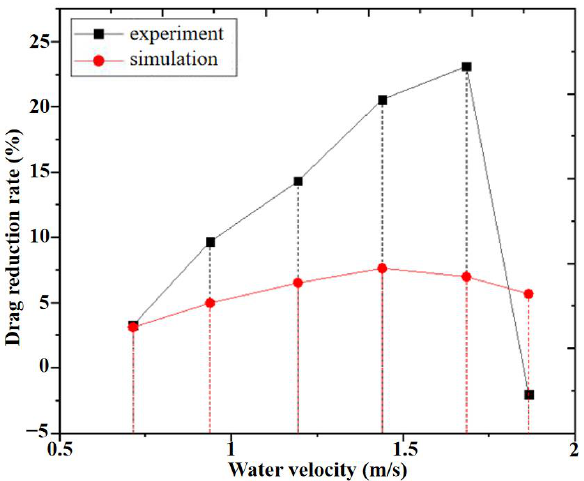
Figure 12. Comparison of experiment and numerical simulation results.